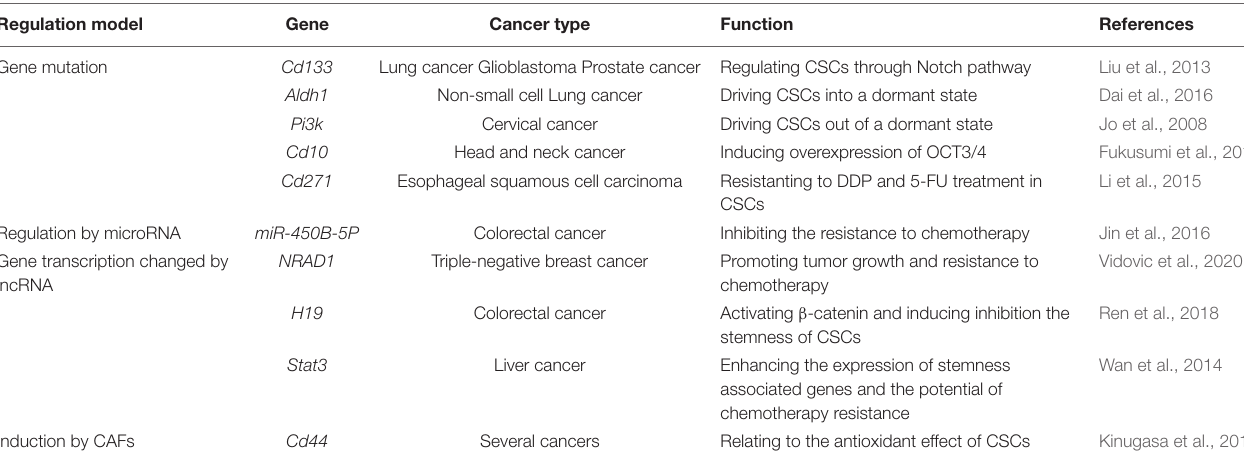
FIGURE 3 | Models of tumor therapeutic resistance. In CSCs model, therapy resistance can be mediated by stem cells. In this model, the tumor contains a small population of CSCs and their differentiated offsprings. With chemotherapy, radiotherapy, or targeted therapy, the DNA damage repair, epigenetic modification, and the effect of the tumor microenvironment on these CSCs make themselves become insensitive to treatments and survive the therapy. The completely differentiated tumor cells are sensitive to treatments and will be killed. Surviving CSCs can further proliferate and differentiate, leading to tumor relapse. TABLE 3 | Genes involved in the therapy resistance of